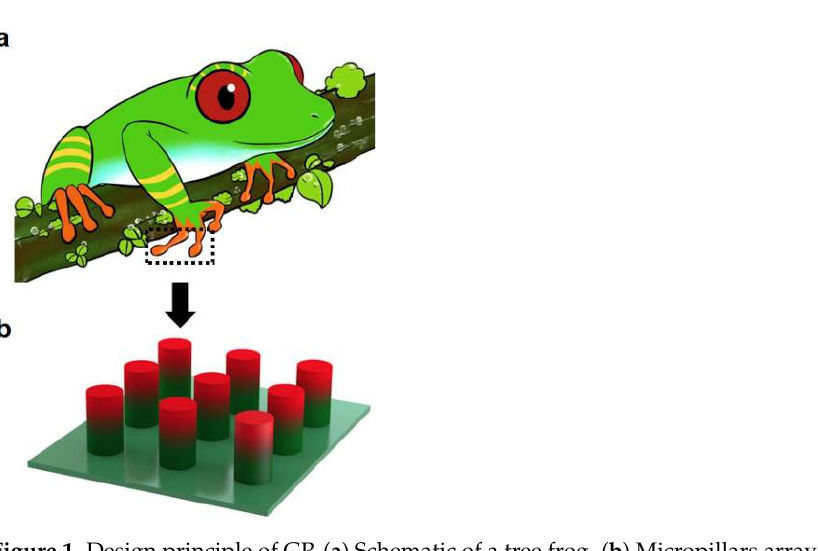
Figure 1. Design principle of GP. ( a ) Schematic of a tree frog. ( b ) Micropillars array inspired by the toe pad of tree frog. Red and green mean relatively larger and smaller elastic modulus, respectively.